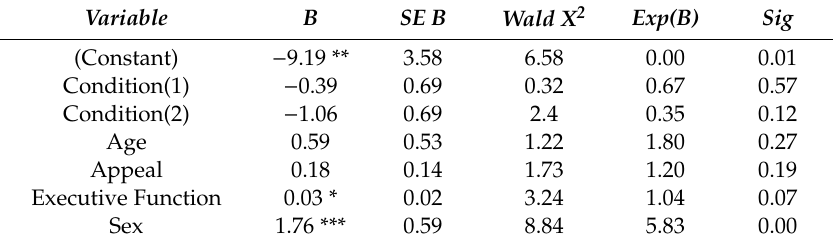
Table 4. Logistic Regression Results for Transfer Task 3; Correctly Balancing the